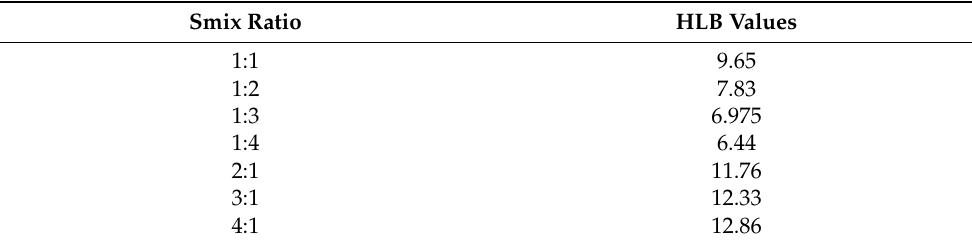
Table 1. Effect of Smix ratio on HLB